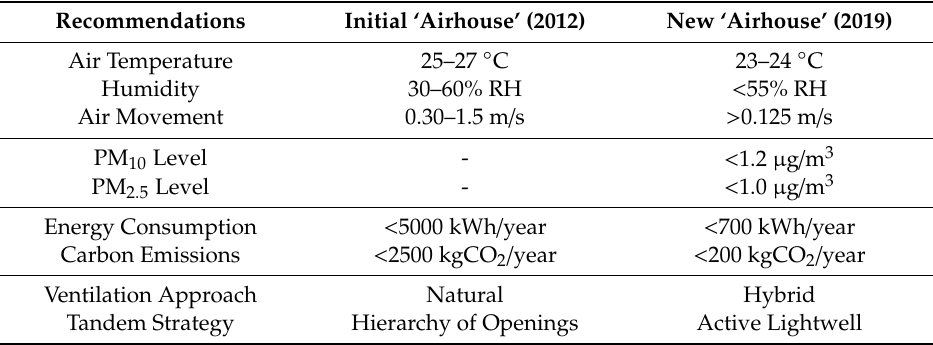
Table 7. Comparison of the initial ‘airhouse’ standard (2012) and the new standard